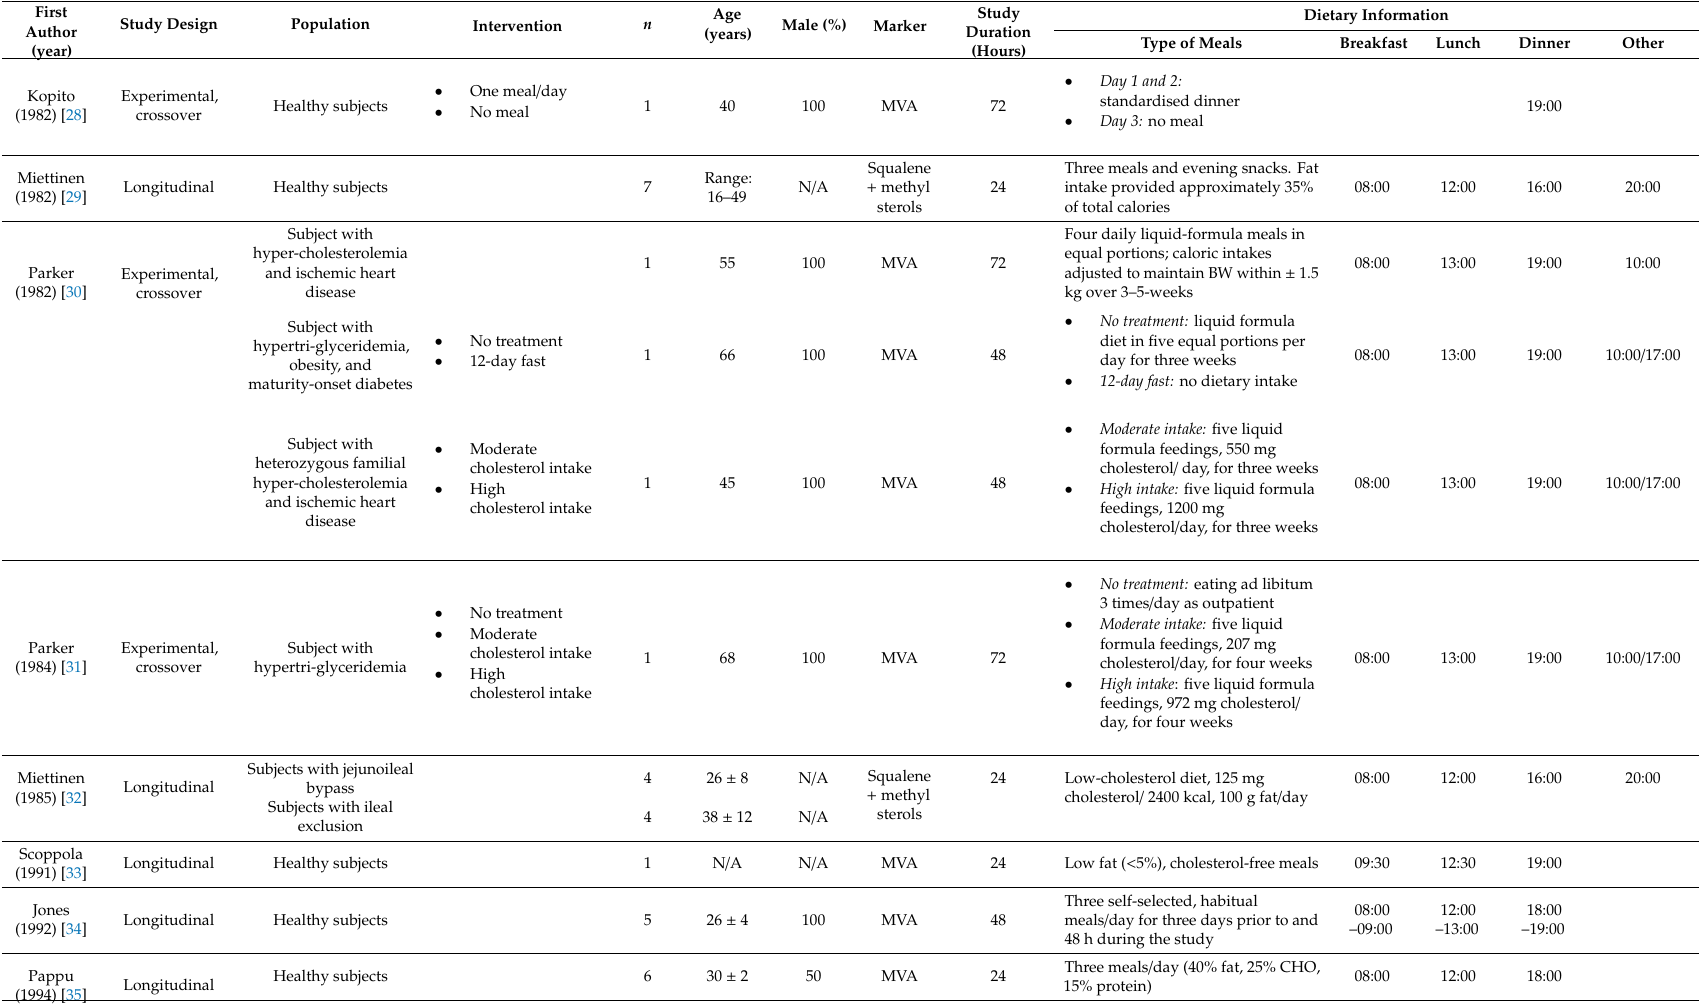
Table 1. Characteristics of studies included in the systematic